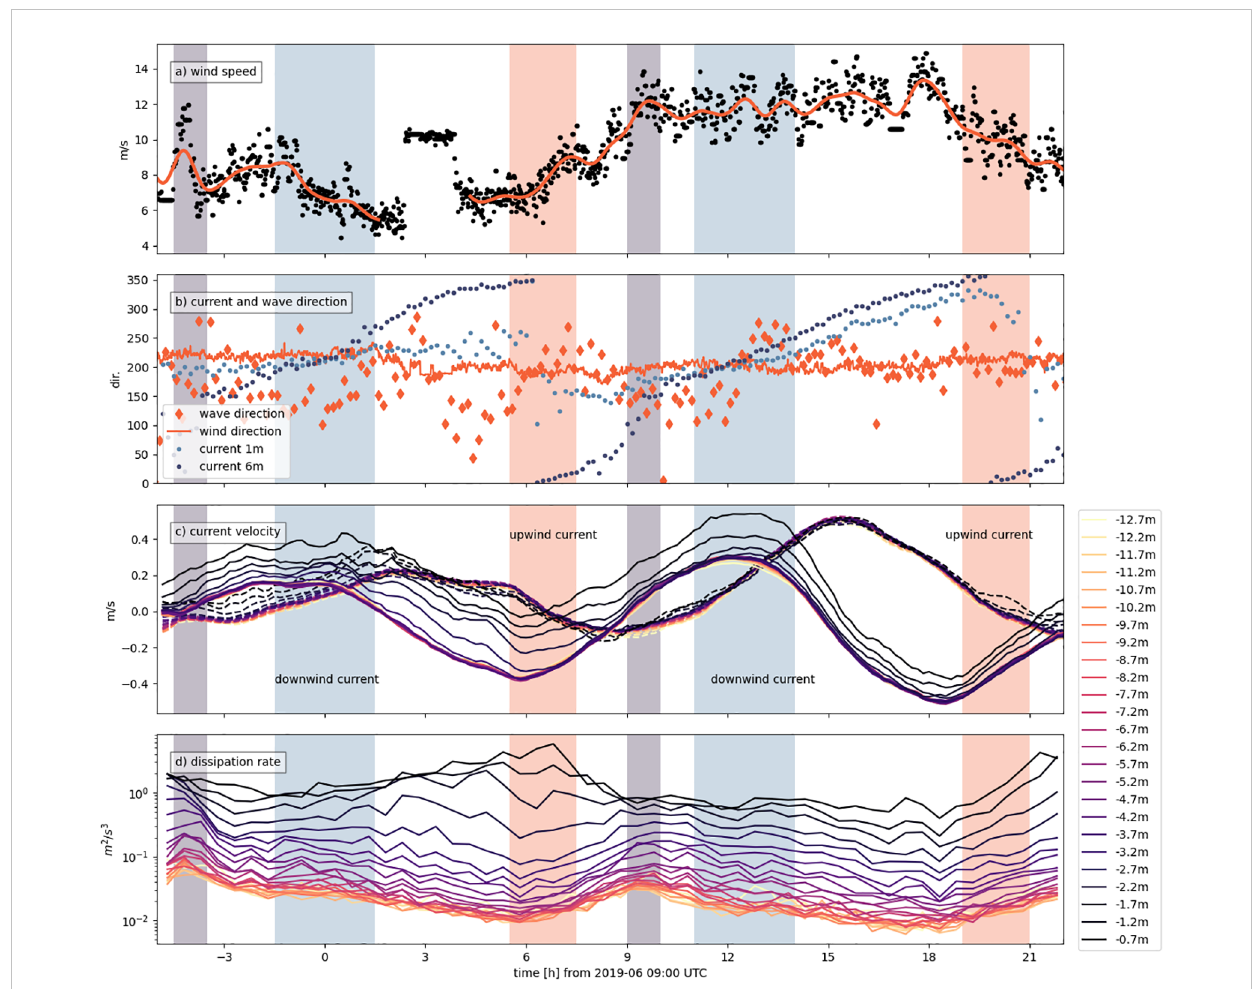
FIGURE 3 Time series of (A) wind speed from ship mast (dots) and low-pass fi ltered (line) (B) current, wave and wind directions, (C) current velocity in along- wind (solid lines) and cross-wind (dashed lines) components as function of depth, and (D) turbulent kinetic dissipation as function of depth. The shaded areas indicate downwind current phase (blue), upwind current phase (red) and 3 hours after upwind phase